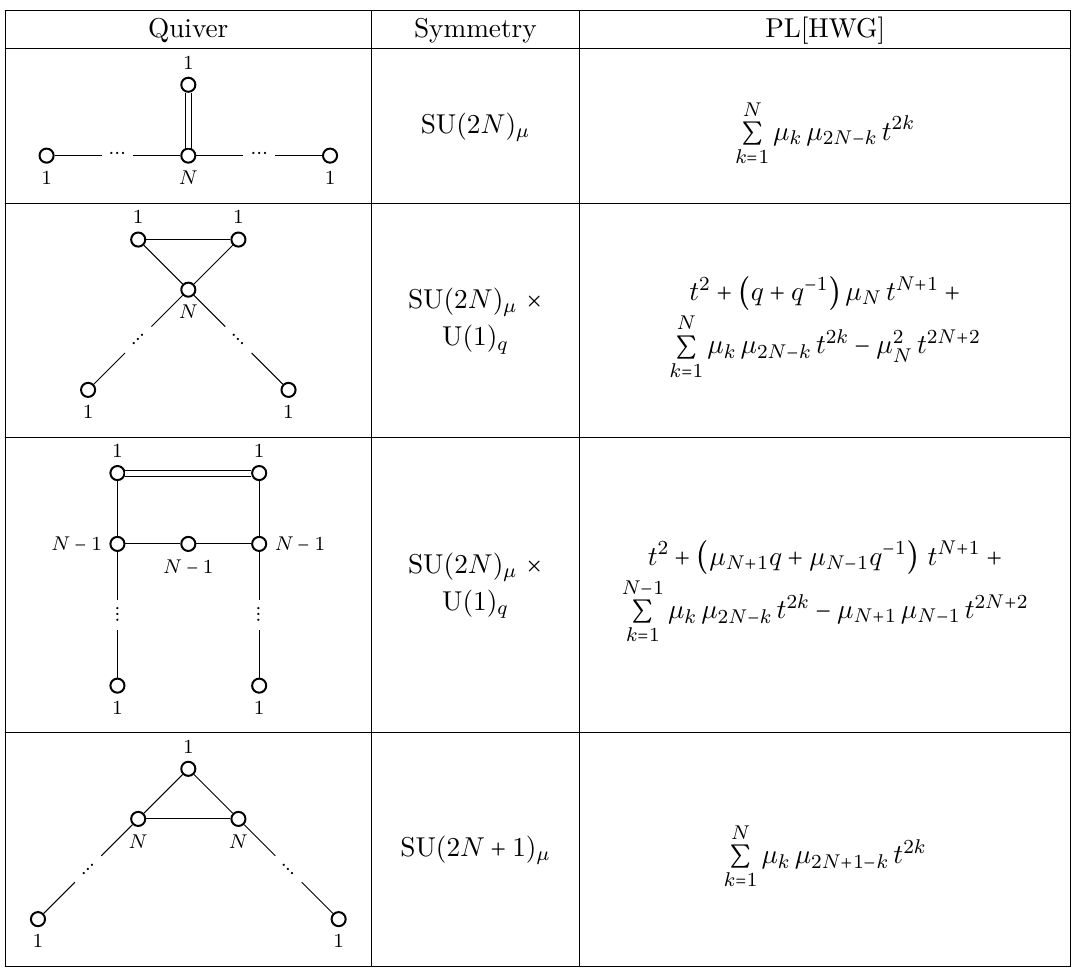
Table 9. List of the HWG for the unitary quivers appearing in the earlier sections. The corre- sponding fugacities are denoted by subscripts in the symmetry groups. Note that for N = 1 , there is a possible enhancement in the symmetry which can be read from the set of balanced nodes in the quivers for N = 1